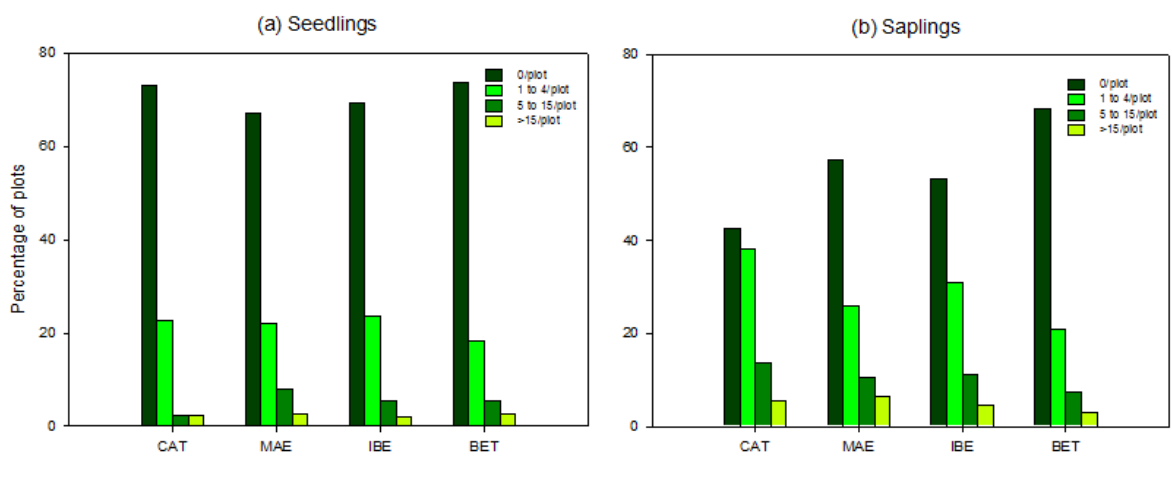
Figure 3. Percentage of plots in the four study regions containing 0 individuals, 1–4 individuals, 5–15 individuals, and more than 15 individuals of Pinus nigra subsp. salzmannii in each of two size classes: ( a ) seedlings (height < 30 cm), and ( b ) saplings (height: 30–130 cm). n = 3226 plots.